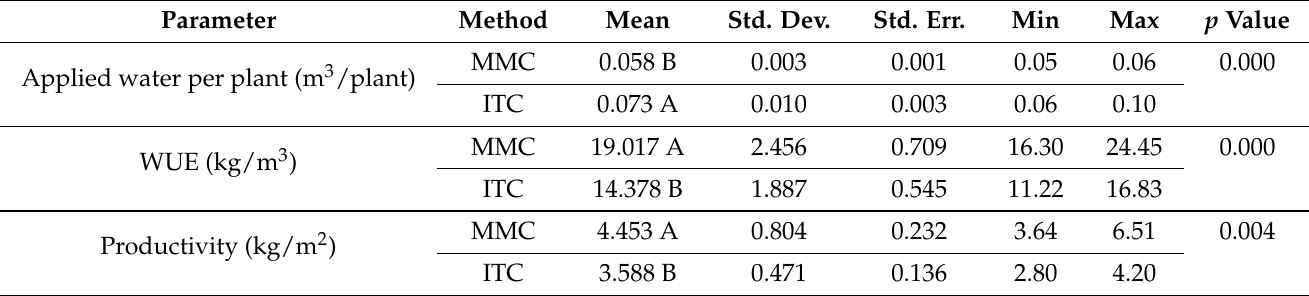
Table 3. Irrigation water applied (m 3 /plant), water use efficiency (kg/m 3 ), and productivity per square meter (kg/m 2 ) of cucumber under different irrigation water control system of medium moisture control (MMC) and irrigation timing (ITC).